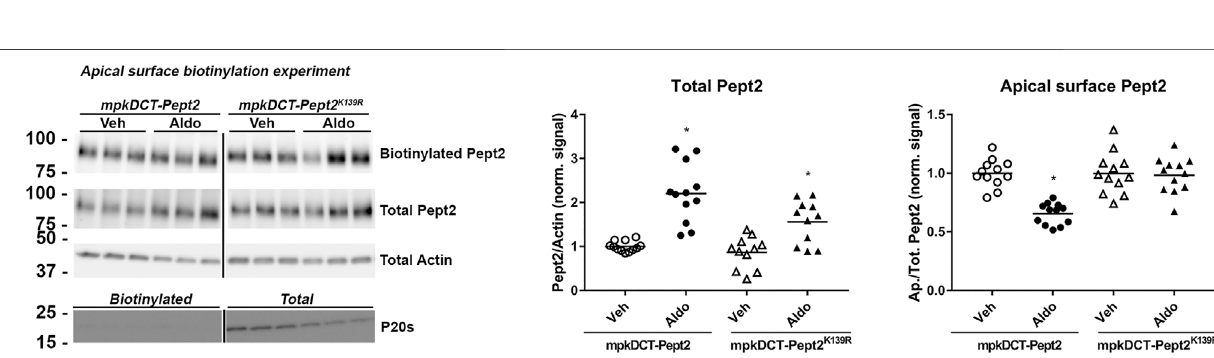
Frontiers in Molecular Biosciences |